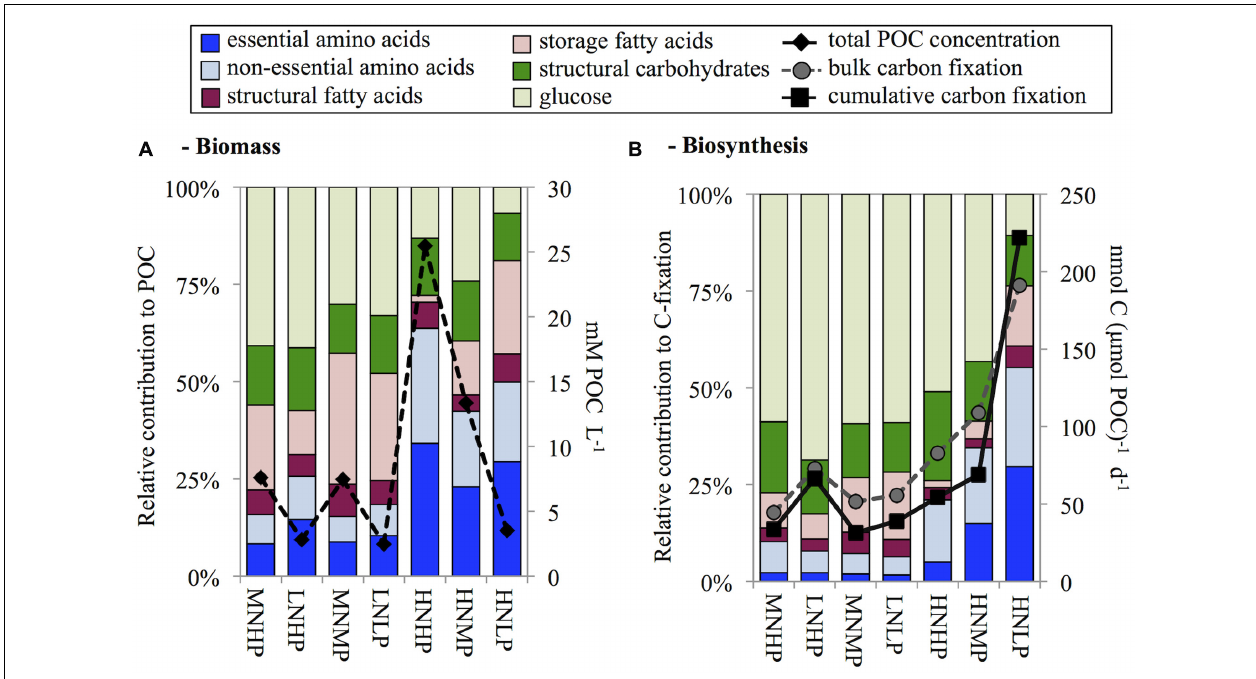
FIGURE 2 | Overview of biomolecule composition of biomass (A) and biosynthesis (B) sorted by DIN:DIP ratios in the chemostats before the 13 C addition experiment. Biomass concentrations are added to panel A as total particulate organic carbon (POC), and both bulk and cumulative carbon fixation are added to panel B